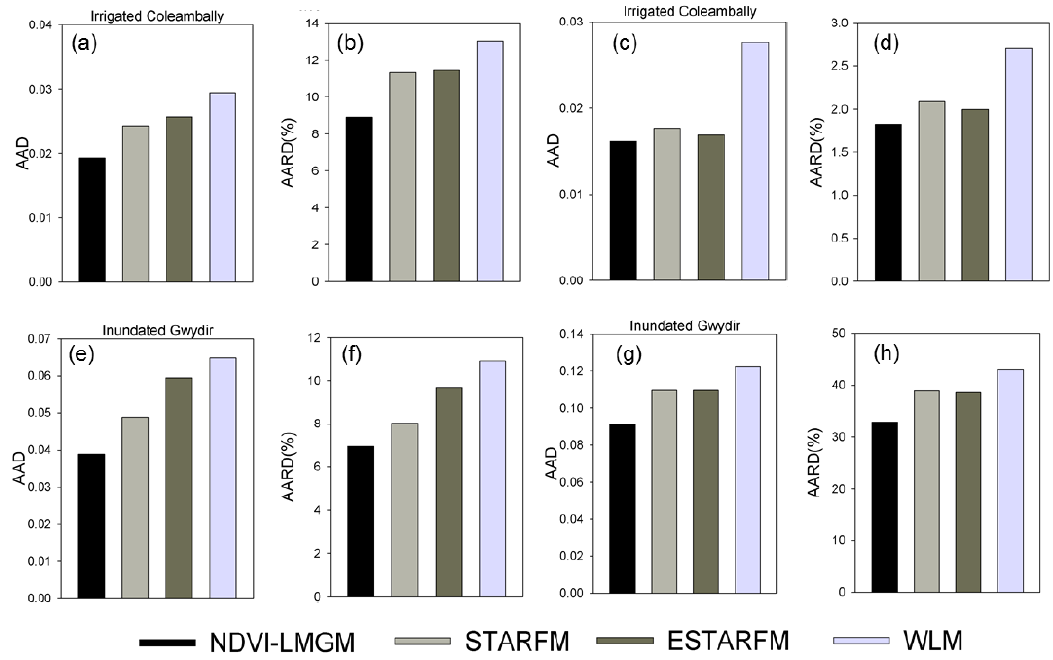
Figure 11. Prediction accuracy assessment (AAD and AARD) for irrigated area of Coleambally on ( a , b ) 17 October 2001 and ( c , d ) 22 February 2002 and inundated area of Gwydir on ( e , f ) 6 August and ( g , h ) 12 December,